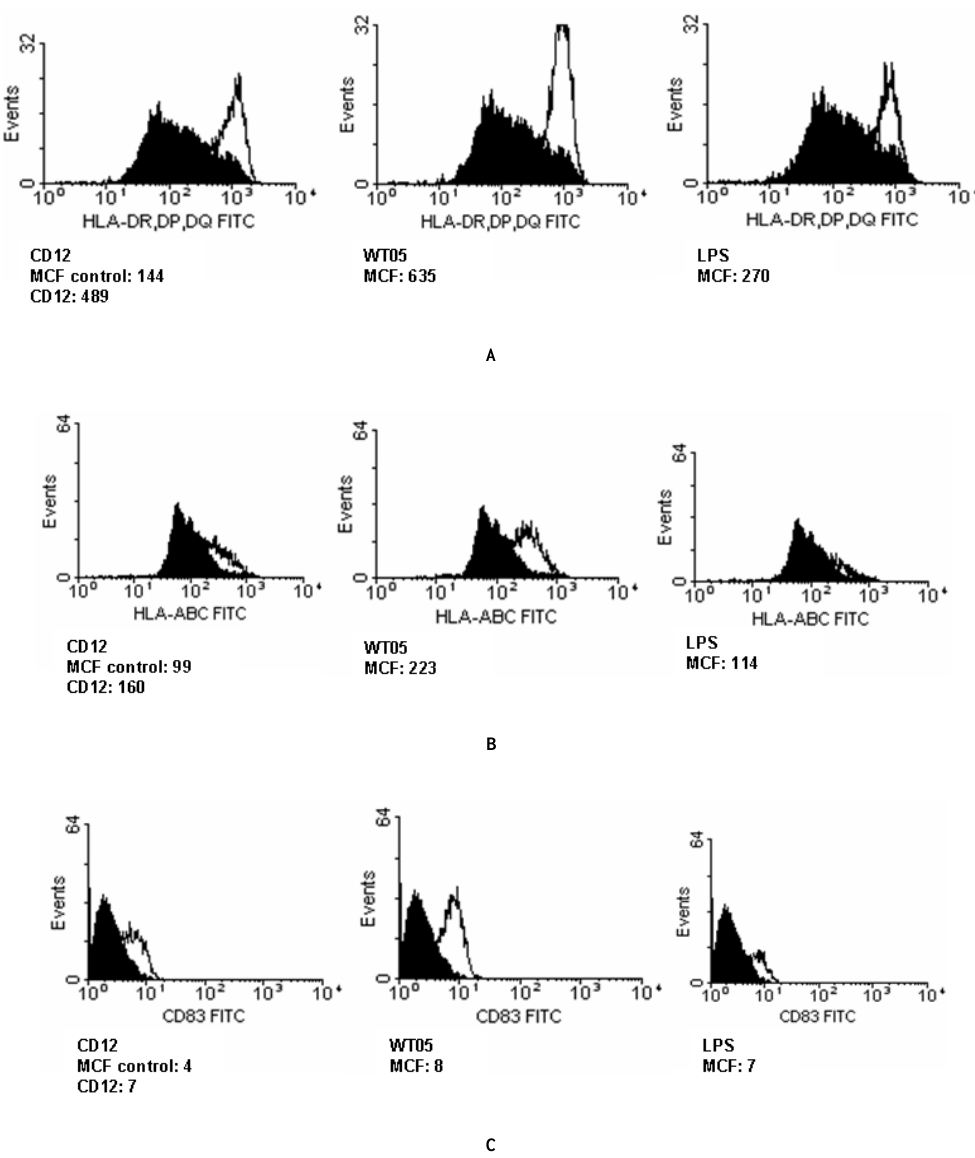
FIGURE 1. Expression of maturation markers on DC infected with S . typhimurium . Graphs show FACS staining data and expression of MHC II (HLA-DR, DP, DQ) (A), MHC I (HLA-ABC) (B), CD83 (C), CD86 (D), CD40 (E) of control (uninfected, black filled-in graphs) DC; DC matured with S. typhimurium strain CD12 (black line, empty graph); DC matured with S. typhimurium WT05 (black line, empty graph); DC matured with S. typhimurium wild-type LPS (black line, empty graph), respectively. MCF is marked under each graph. Infection of DC with strain WT05 resulted in higher expression of maturation markers than strain CD12 or exposure to S . typhimurium LPS. (Analysed on the WinMDI